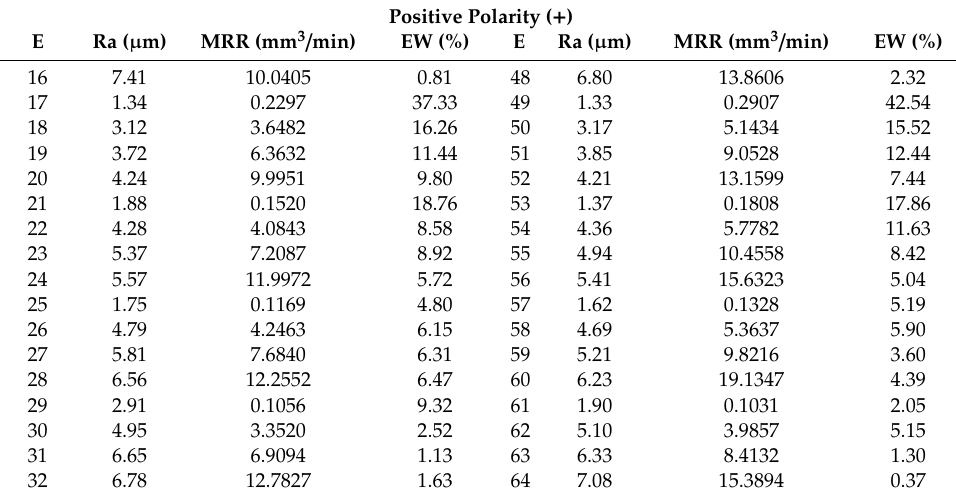
Table A2. Mean values of Ra, MRR, and EW, obtained with negative polarity. These values were taken from Reference [2] Torres Salcedo, A.; Puertas Arbizu I.; Luis P é rez, C. J. Analytical Modeling of Energy Density and Optimization of the EDM Machining Parameters of Inconel 600. Metals 2017, 7,